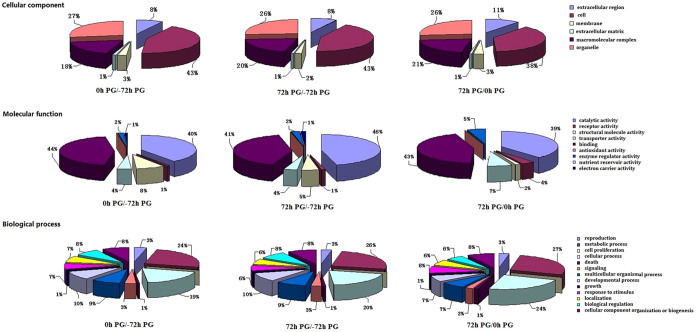
Gene ontology (GO) term distributions (the second level) for three categories.GO analysis was performed using the Cytoscape software ver. 2.6.2 according the differentially expressed proteins.